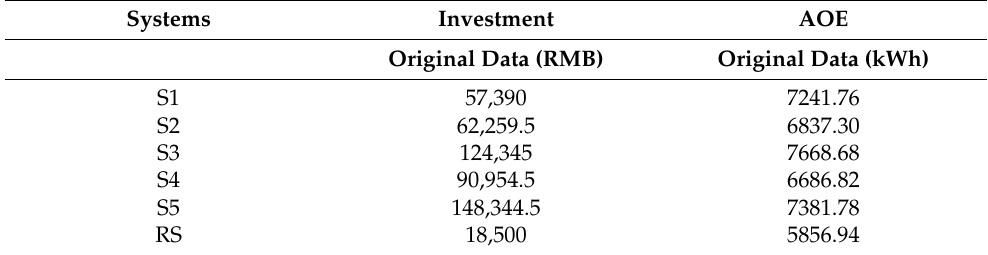
Table 7. Initial investments and simulated annual energy performance of different HVAC systems.